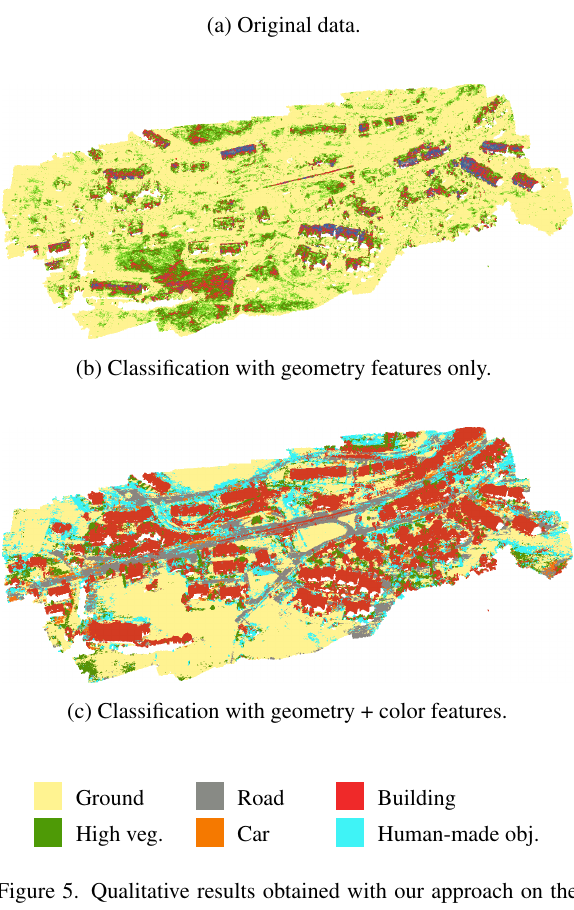
Figure 5. Qualitative results obtained with our approach on the Cadastre dataset, using the other two datasets for training. We used neighbor color features within a 0.6-meter radius neighbor- hood and the Gradient Boosted Trees classifier. Using color in- formation results in a more accurate